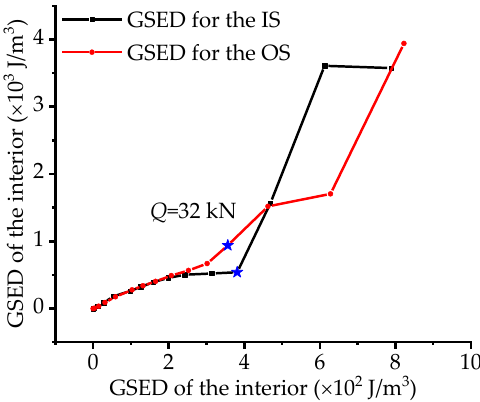
Figure 14. The correlation of the GSED between the exterior and interior.